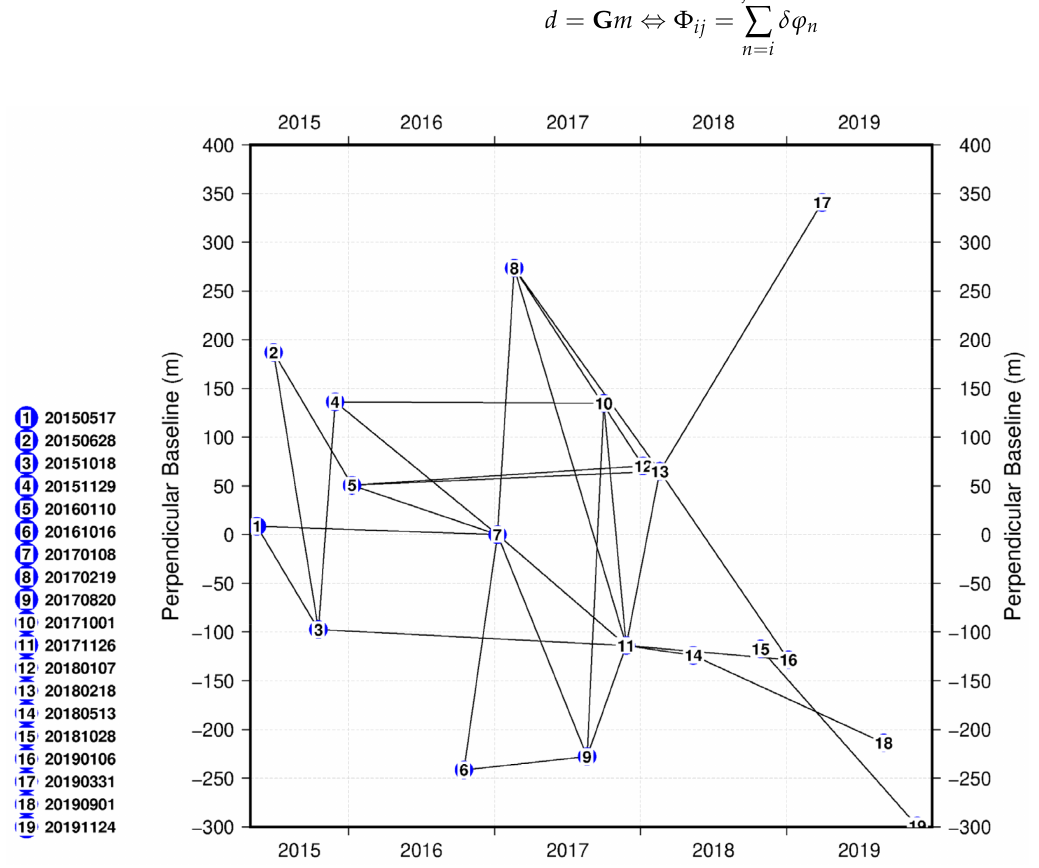
Figure 2. Spatiotemporal baseline network diagram of ALOS-2 descending orbit T48.